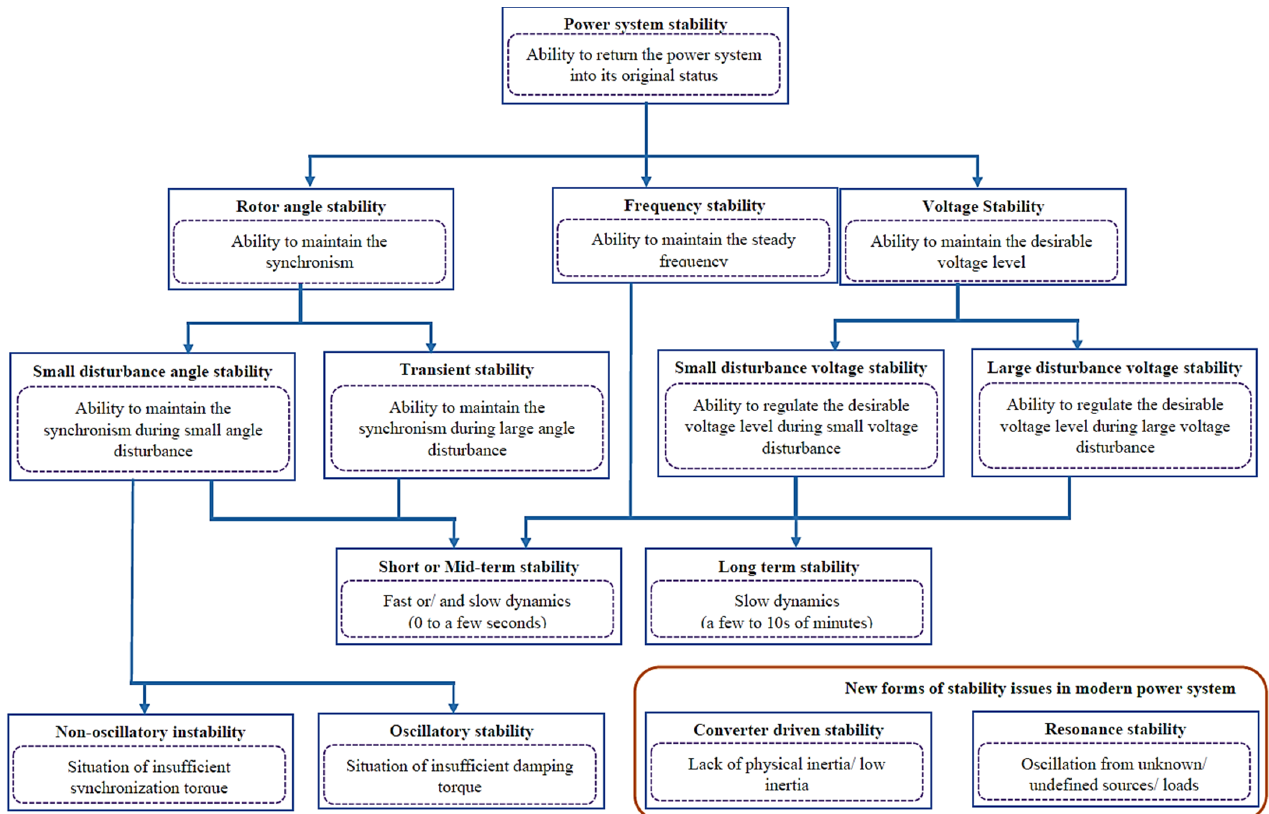
Figure 1. Power system stability classification.